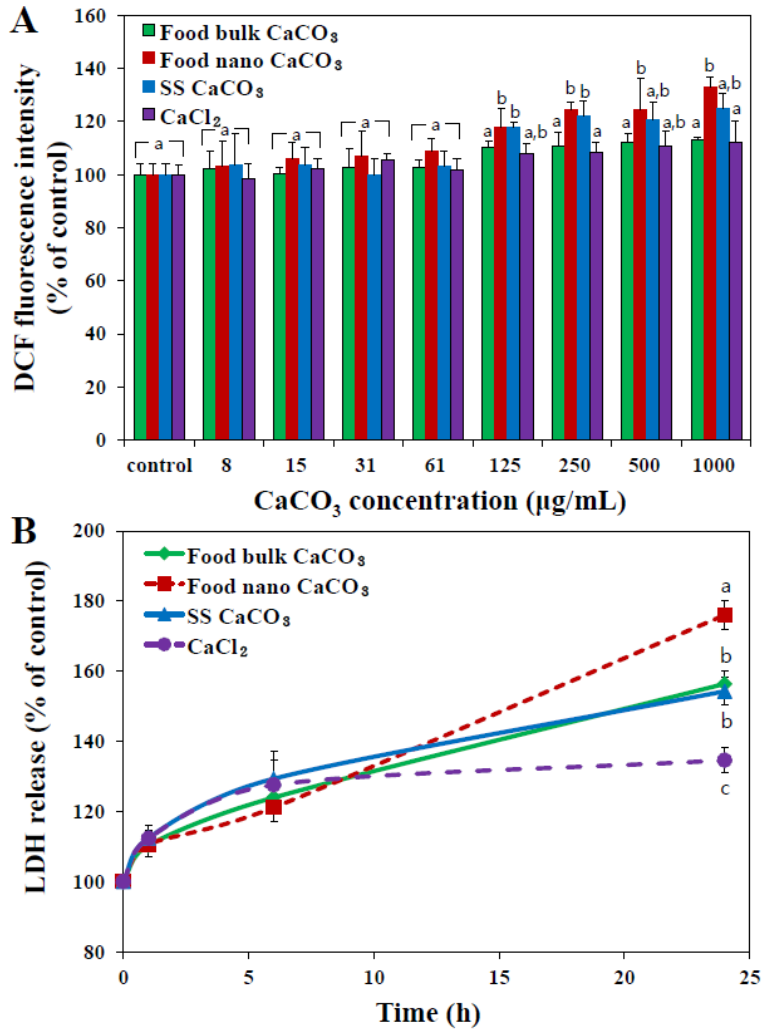
Figure 4. Effect of three different types of CaCO 3 particles or an equivalent amount of CaCl 2 (based on calcium content) on ( A ) ROS generation and ( B ) lactate dehydrogenase (LDH) release from human intestinal INT-407 cells after 24 h of incubation. The mean values with different letters (a, a,b, b, c) at the same concentration or time points indicate statistically significant difference ( p <